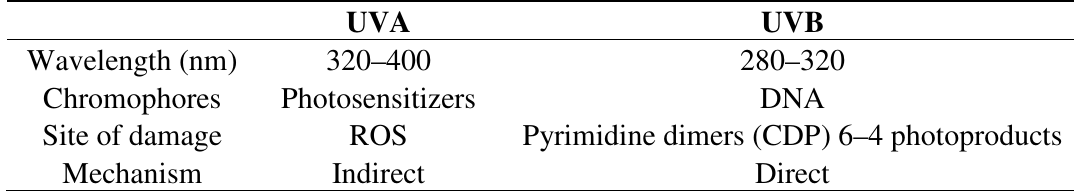
Table 1. Summary of mutagenic effects of UVA and